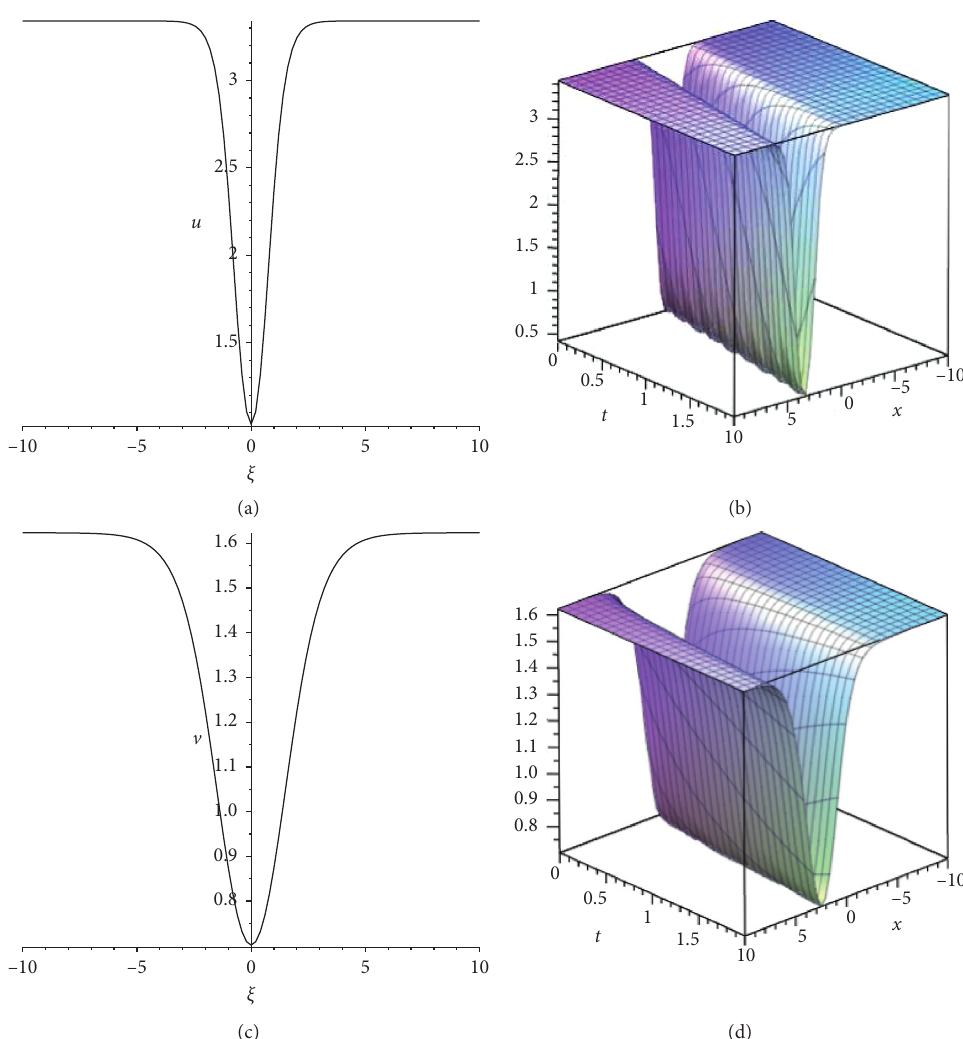
( 􏽥 u , 0 ) , 􏽥 E ( 􏽥 u , 0 ) , and 􏽥 E 4 4 5 5